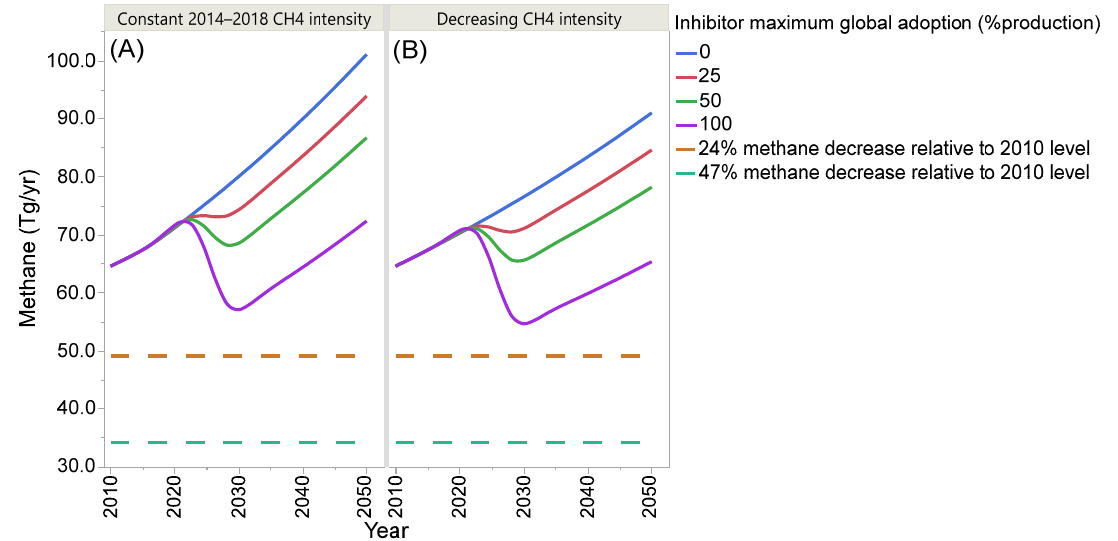
Figure 4. Predicted evolution of enteric methane (CH 4 ) emissions from global beef, lamb, and bovine milk production between 2010 and 2050 considering ( A ) constant CH 4 intensity and ( B ) declining CH 4 intensity according to Table 1. Adoption of feed additive inhibitors of methanogenesis decreasing CH 4 intensity by 26.6% for beef and lamb and by 31.8% for milk production is simulated to occur at 0, 25, 50, or 100% of global production. Decreases in enteric CH 4 emissions of 24 and 47% relative to 2010 required to maintain a global temperature increase within 1.5 °C according to different socioeconomic scenarios and climate models [15] are shown in dashed lines.